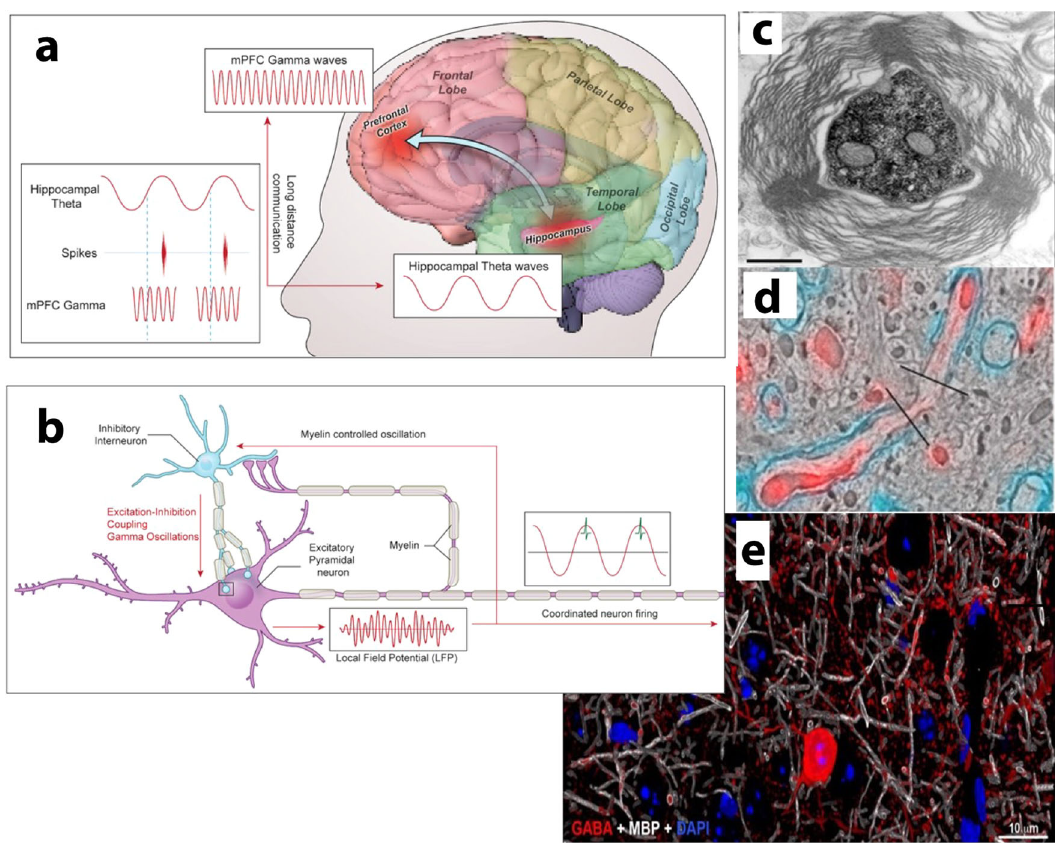
Fig. 2 Myelin plasticity contributes to learning and memory by altering the frequency, phase and amplitude coupling of neural oscillations. a Conduction latency will have a profound in fl uence on phase and frequency coupling of neural oscillations between distant brain regions that are critical for memory induction and recall. b The frequency of oscillations in local circuits, such as gamma oscillations in cerebral cortex, will be affected by conduction velocity in axons between inhibitor and excitatory neurons. Excitatory-inhibitory coupling between inhibitory interneurons and excitatory pyramidal neurons generate gamma oscillations. The frequency of oscillation is affected by the strength and latency of synaptic transmission, which is in fl uenced by myelination of axons on inhibitory and excitatory neurons. Action potential fi ring (green) is entrained by the phase and frequency of subthreshold neural oscillations and local fi eld potentials. c Myelinated projecting axons from inhibitory neurons in CA1 of the hippocampus to the subiculum. Myelin sheath thickness and axon diameter are larger in axons from hippocampal inhibitory neurons that project over long distances than CA1 axons from excitatory neurons to provide more rapid conduction velocity to sustain neural oscillations at appropriate phase and frequency between hippocampus and cortical regions participating in memory formation and recall. The apparent loose compaction of myelin is an artifact of fi xation necessary for immunocytochemistry. Reprinted from Jinno et al., (2007) 95 with permission (copyright 2007 Society for Neuroscience). d Scanning electron micrograph of a node of Ranvier on an axon of an interneuron in the cerebral cortex, immunolabeled with myelin basic protein (cyan) and GABA (red). e A large fraction of inhibitory interneurons are myelinated in cerebral cortex. GABA (red), myelin basic protein (white), nuclei stained with DAPI